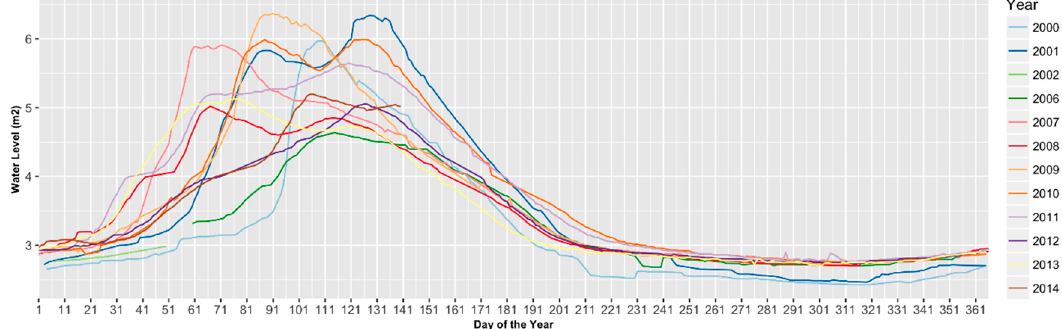
Figure 11. Stage of Chobe River at Marina Lodge, Kasane, Botswana (Data courtesy of the Department of Water Affairs office in Kasane, Botswana).